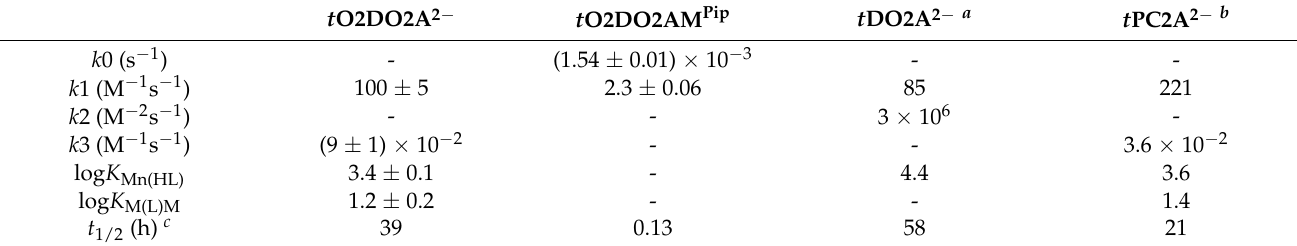
Table 4. Rate and equilibrium constants and half-lives of dissociation (pH = 7.4) determined for the Mn(II) complexes of t O2DO2A 2 − and t O2DO2AM Pip (T = 25 ◦ C and I = 0.15 M NaCl) and related systems provided for